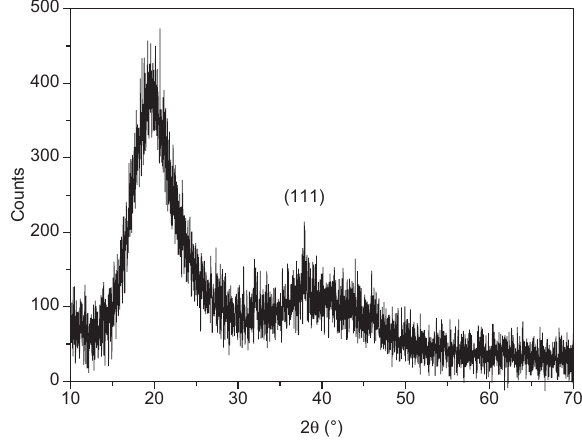
Figure 2 XRD of Ag/PS nanocomposite obtained by thermally decomposing [Ag(hfac)(COD)] dissolved in